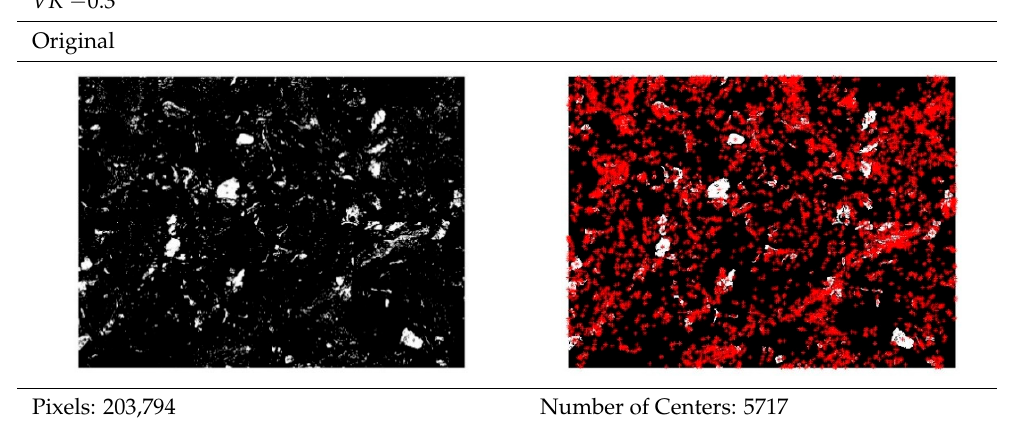
Table A6 . Images and associated pixels and number of centers corresponding to VR = − 0.3.